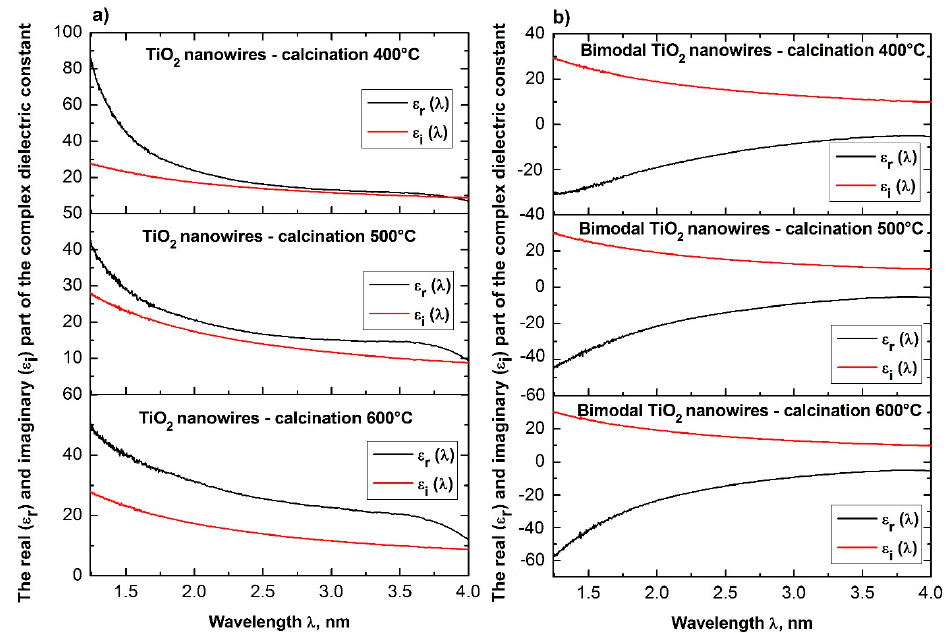
Figure 15. Dependences of the real ε r ( λ ) ( a ) and imaginary ε i ( λ ) parts ( b ) of the complex dielectric constant for the produced TiO 2 ceramic nanowires and bimodal TiO 2 /TiO 2 nanowires.